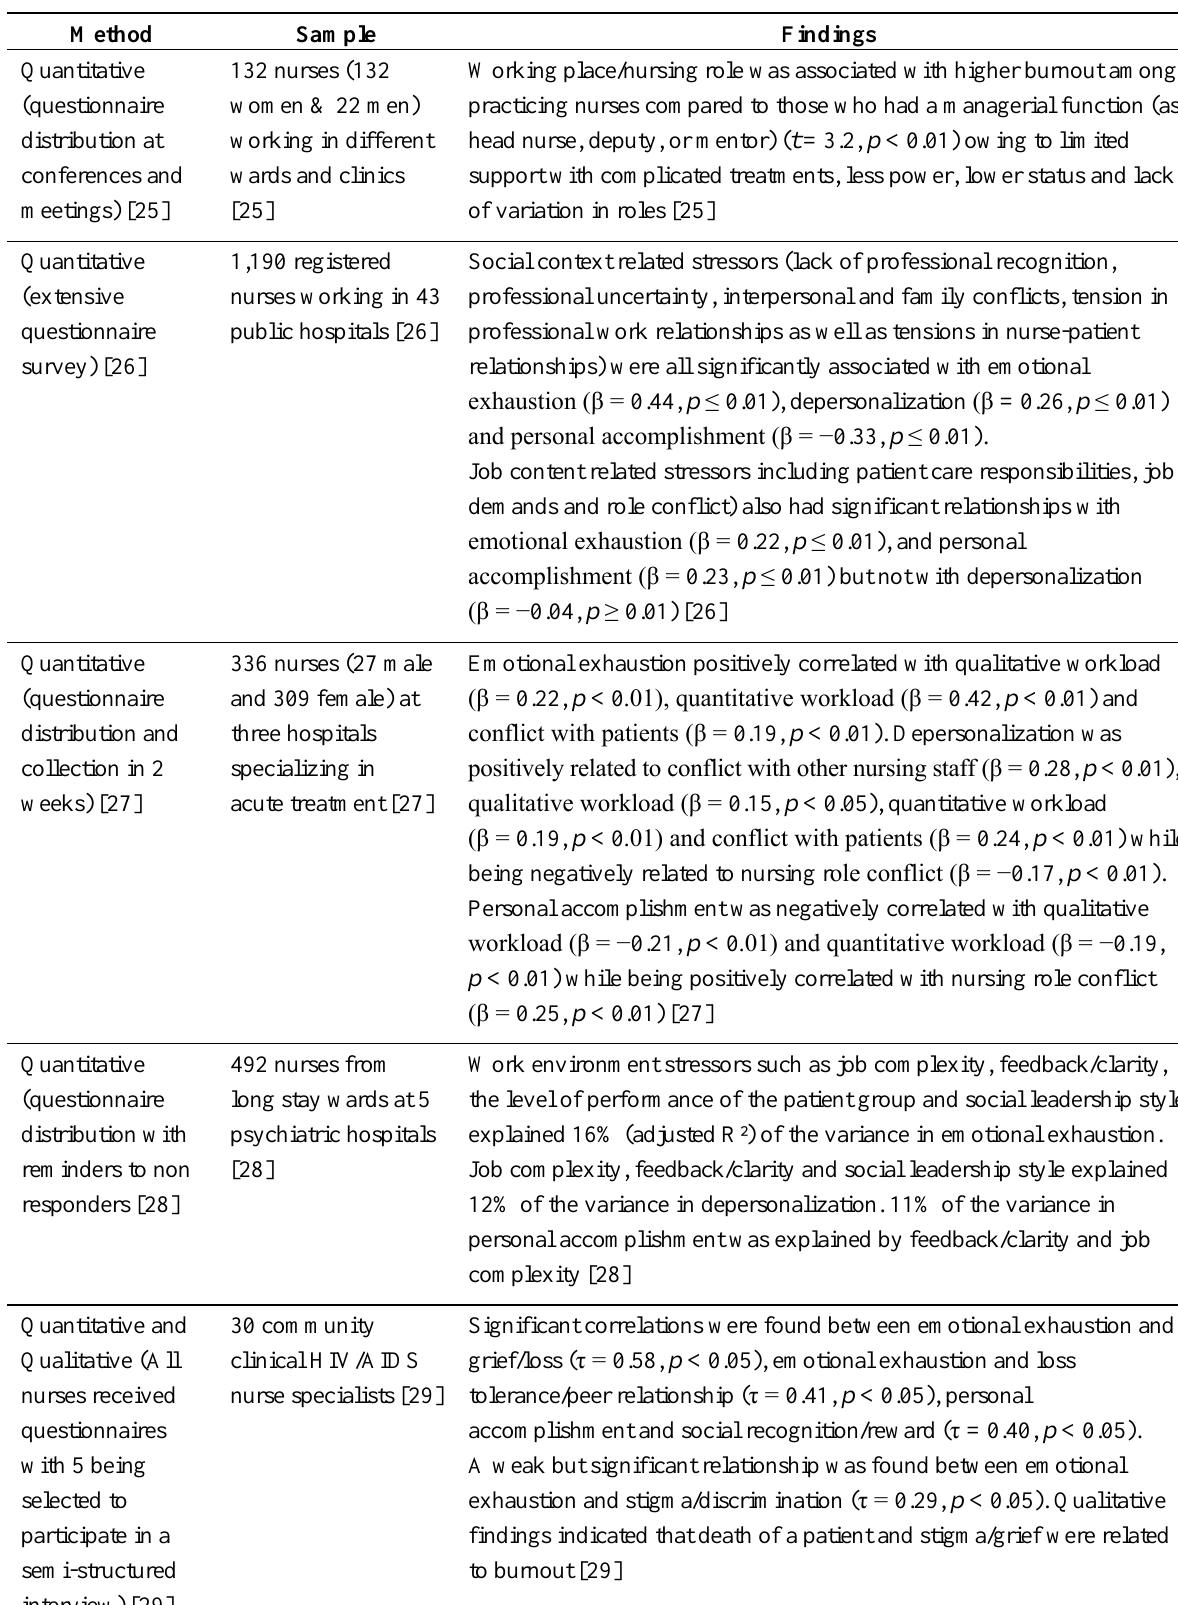
Table 1. Method, sample and findings of identified